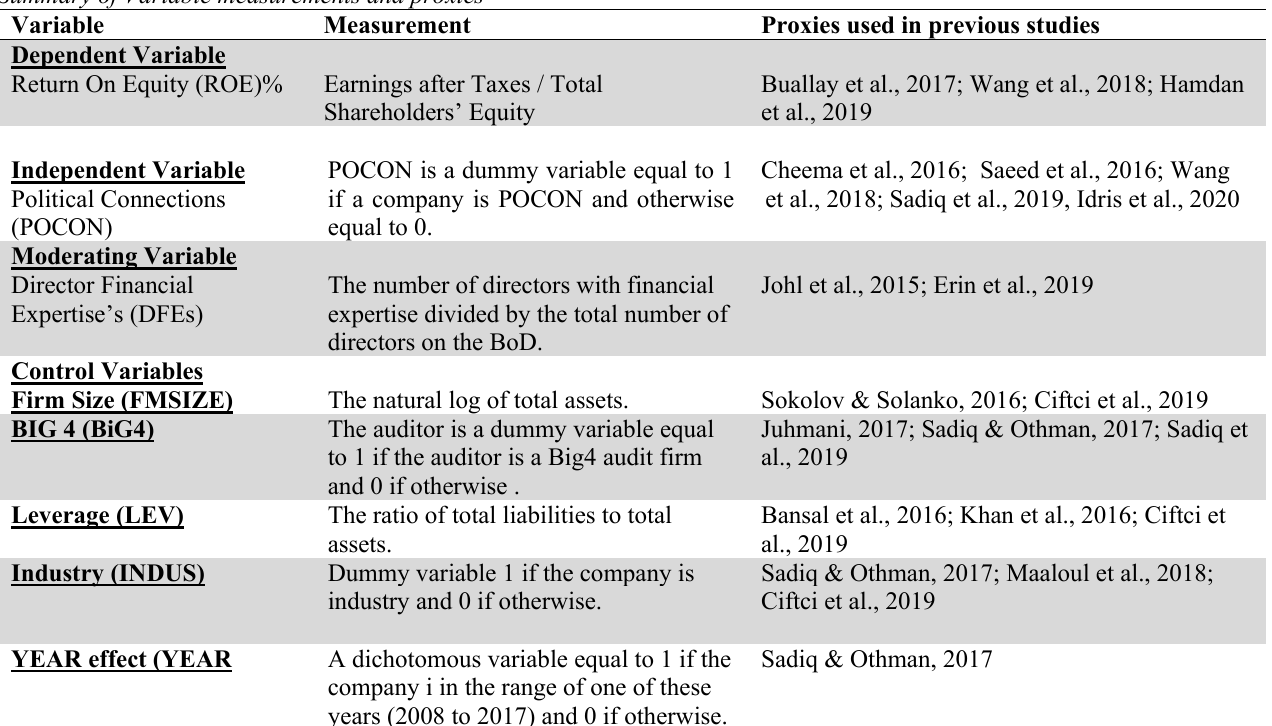
Summary of Variable measurements and